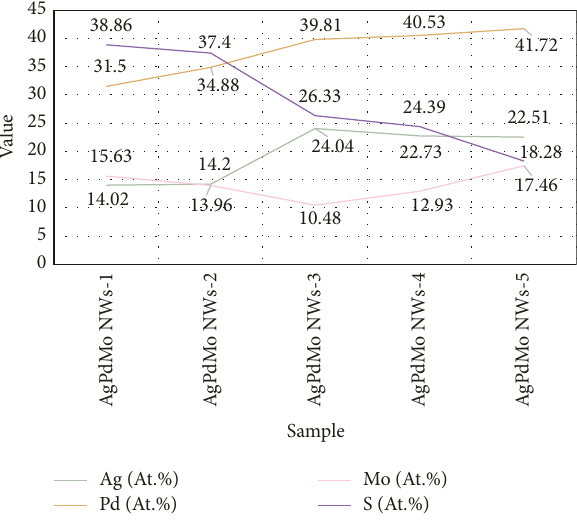
Figure 6: Energy dispersive X-ray spectroscopy test results.